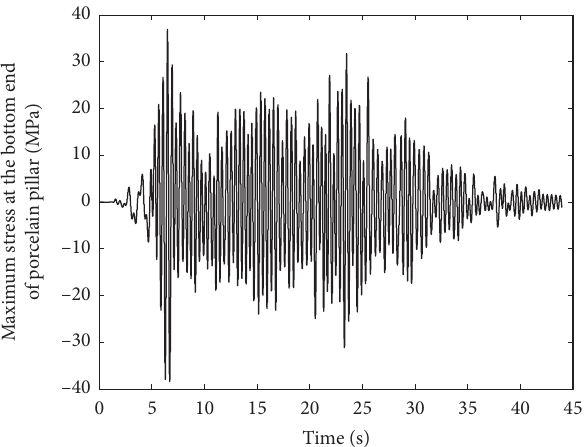
Figure 19: Maximum stress at the bottom of porcelain pillar ( a � 0.5 g, η �